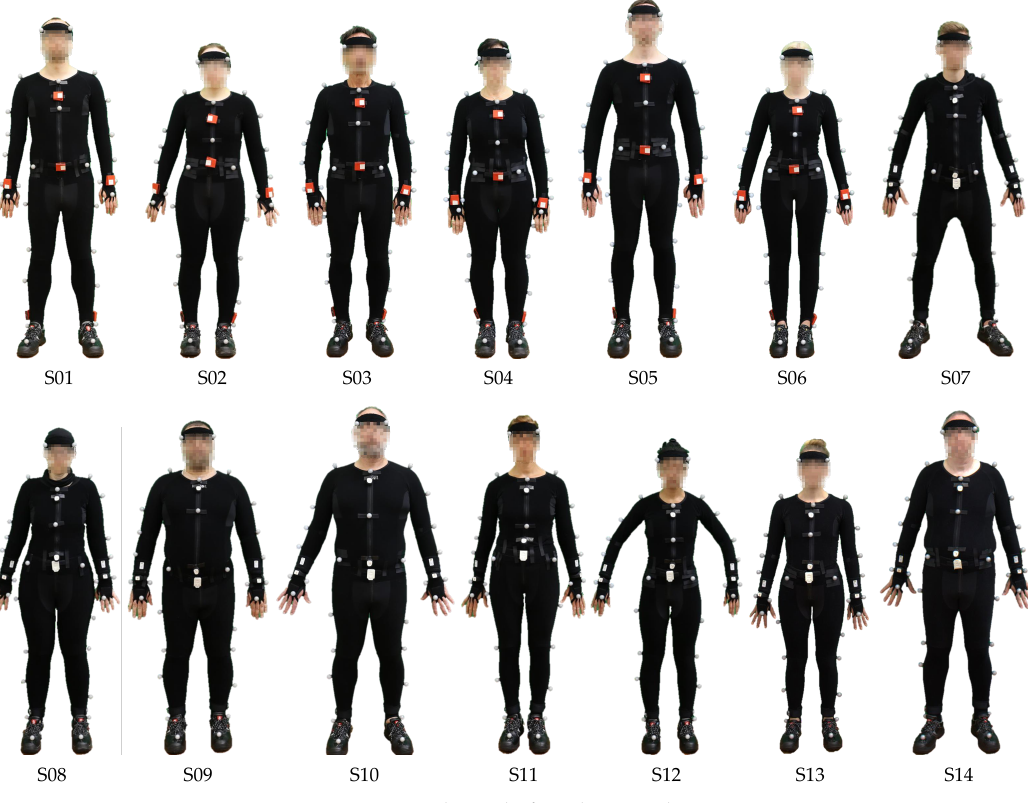
Figure 10. Subjects before the